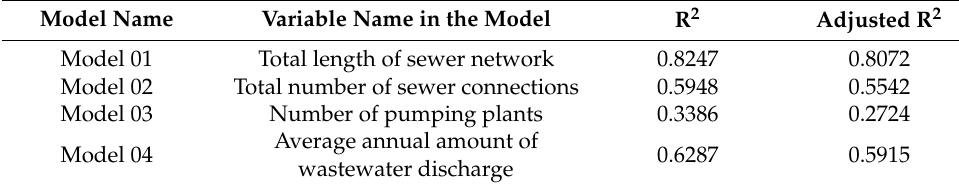
Table 7. Proposal for variables of the maintenance cost models with one variable.